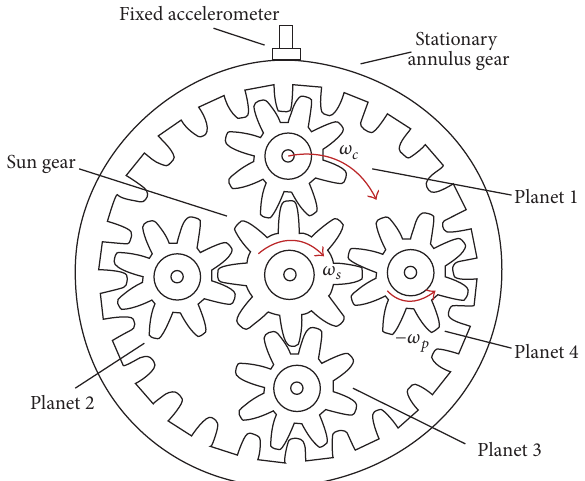
Figure 1: A typical configuration of planetary gear-set with 4 equally spaced planet pinions and an accelerometer mounted on the stationary annulus